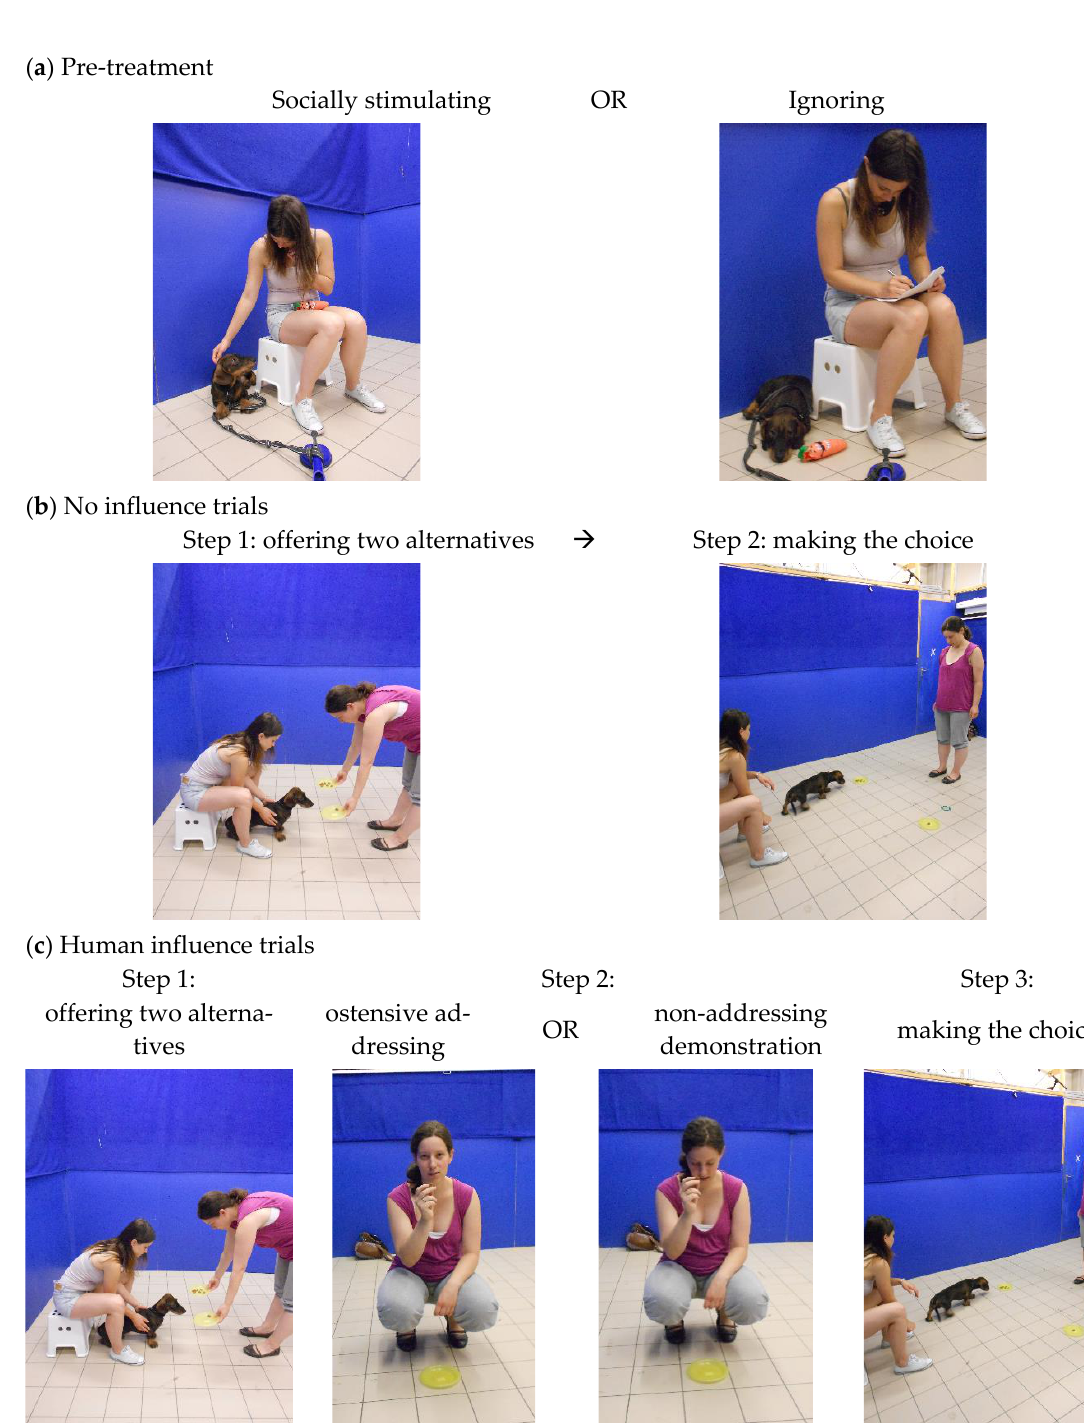
Figure 1. Photo illustration of the main phases of the experimental procedure. ( a ) Different types of pre-treatments. ( b ) Different steps of the ’No influence’ trials in the quantity discrimination task (trials 1 – 6). ( c ) Different steps of the ‘Human influence’ trials in the quantity discrimination task (trials 7 – 12).